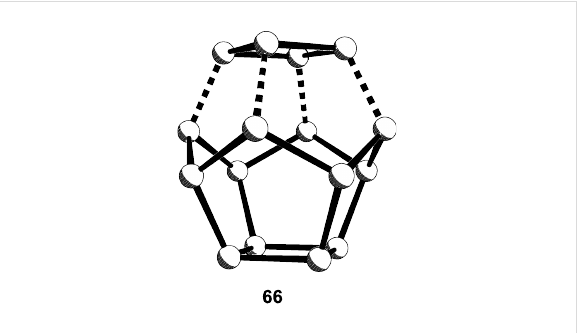
Figure 6: Capping [4]peristylane with a four-membered ring